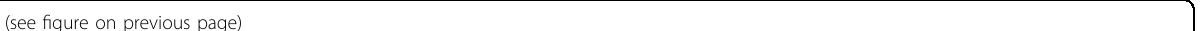
Fig. 5 Methotrexate synergized with gemcitabine in cholangiocarcinoma via MTHFD1 -mediated ROS restoration. A , B QBC939 was treated with MTX at the indicated concentrations or PBS for 48 h. Relative expression of MTHFD1 of mRNA and protein was measured. C HyPer-Low and HyPer-High subpopulations were treated with MTX at the indicated concentrations for 48 h. Relative expression of MTHFD1 mRNA was measured. D QBC939 was treated with PBS, H 2 O 2 , and MTX respectively at the indicated concentration. The ratio of the HyPer3 probe was measured by fl ow- cytometric analysis. E The sorted cells were seeded in 6 well plates for 24 h and followed with gemcitabine treatment for 48 h at 1 and 10 μ M combine with MTX. Apoptotic assay by Hoechst dye for immuno fl uorescence after gemcitabine treatment for 48 h. F Sorted cells were treated with Gemcitabine at the indicated concentrations with MTX at indicated concentrations respectively for 48 h. Cell viability was measured using CCK8. G Apoptotic assay by Annexin-V/PI staining for fl ow cytometry after treated with gemcitabine at the indicated concentrations with MTX at indicated concentrations respectively for 48 h for sorted cells. H Quanti fi cation of G . Each experiment was performed in triplicate.* p < 0.05; ** p < 0.01; *** p < 0.001.